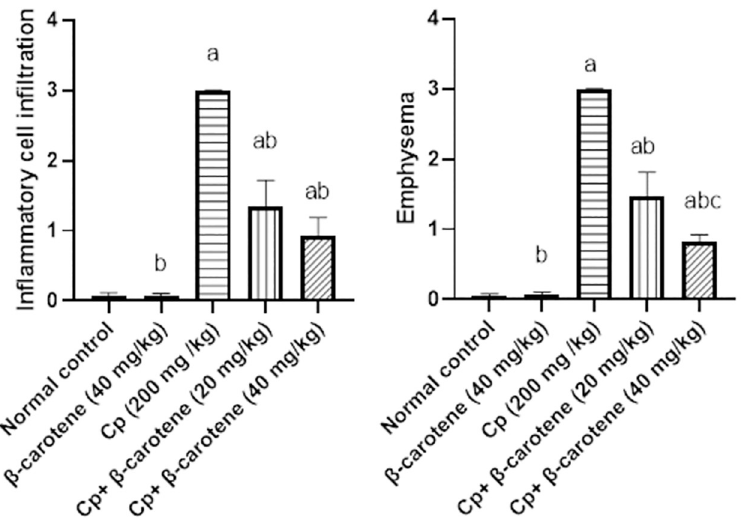
Fig 10. Effect of β -carotene on histomorphometric analysis. a Significantly different from the control group. b Significantly different from the CP group. c Significantly different from the CP + β -carotene 20 mg/kg group at P < 0 . 05